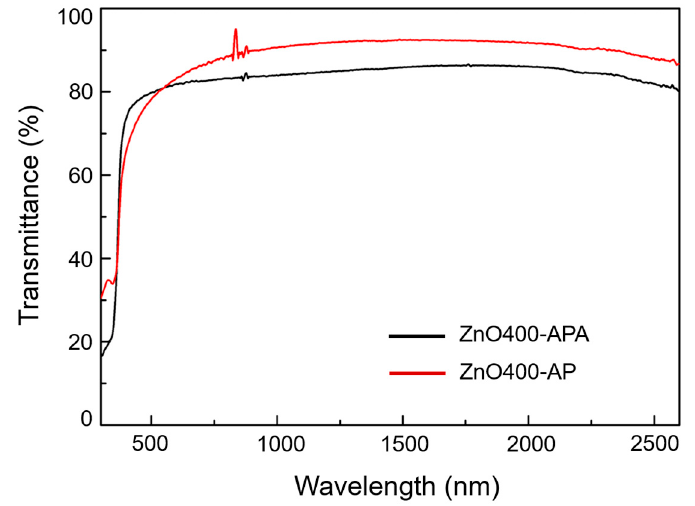
Figure 8. Comparison of transmittance of ZnO400-APA and ZnO400-AP.